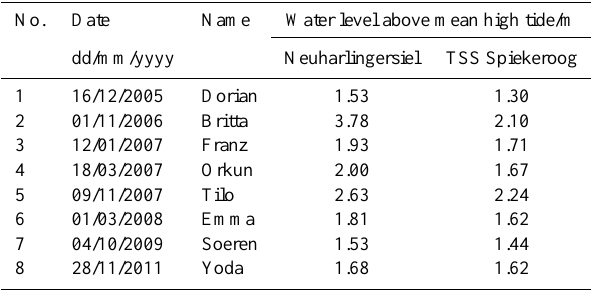
Table 3. Water levels of storm floods above the mean high tide in Neuharlingersiel and at the Time Series Station Spiekeroog between 2005 and 2011. Water level between 1.5 and 2.5m characterise a weak storm flood, between 2.5 and 3.5m characterise a severe storm flood and values above 3.5m indicate a very severe storm